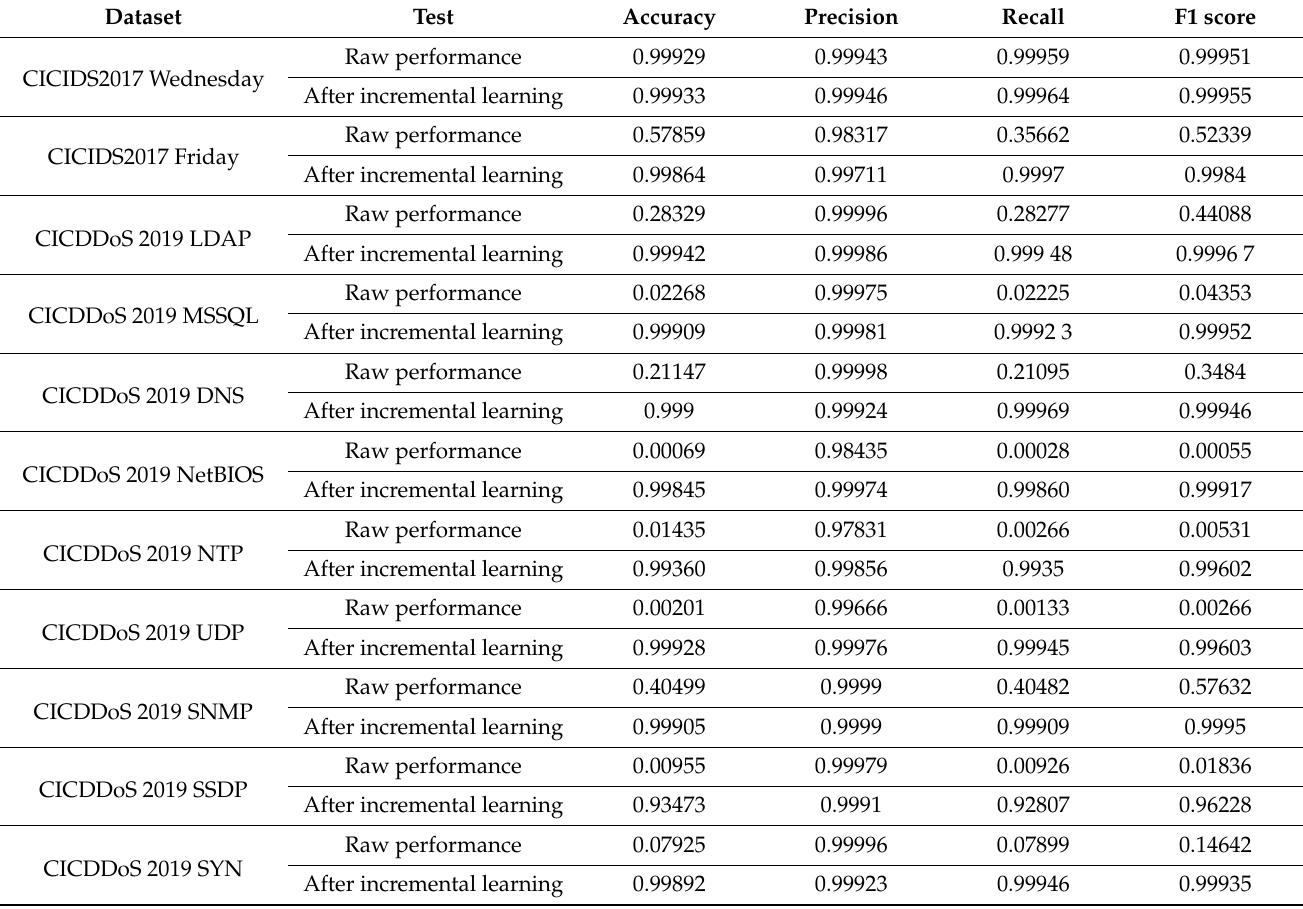
Table 9. Model’s defending results after incremental